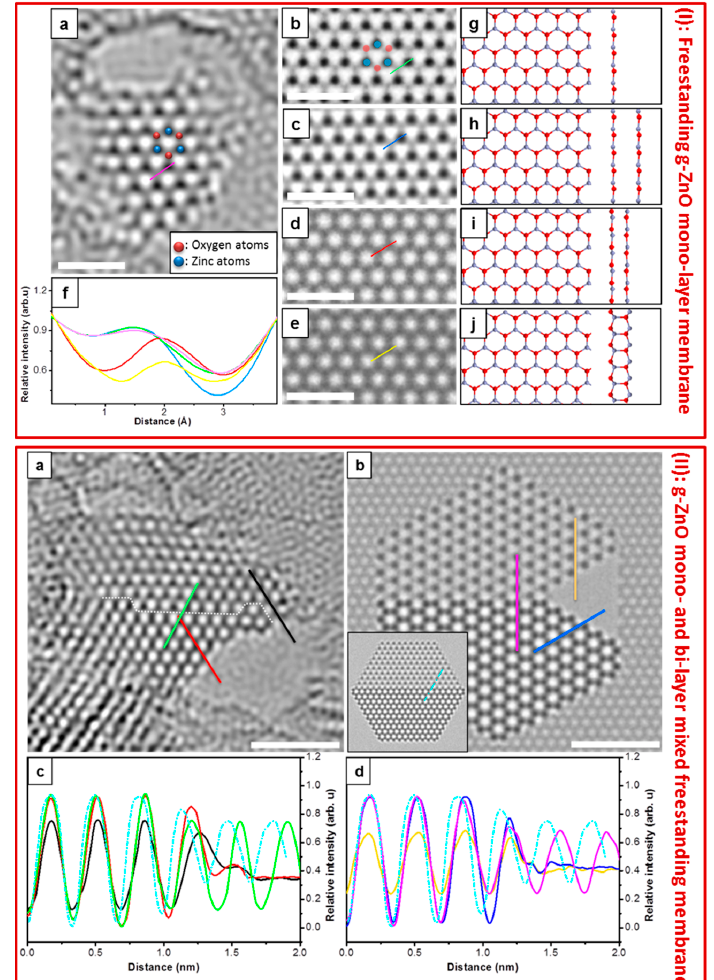
Figure 5. Frame ( I ): Mono-layer g-ZnO freestanding in a graphene pore. ( a ) TEM micrograph showing g-ZnO membrane within a graphene hole. ( b – e ) Simulated images of mono-layer and bi-layer T1, T2 configuration as well as wurtzite structure of ZnO, respectively. ( f ) Normalized intensity profiles from experimental image (pink line in panel a), simulated images of mono-layer (green line, panel b), bi-layer T1 (blue line, panel c), bi-layer T 2 (red line, panel d), bi-layer wurtzite (yellow line, panel e). ( g – j ) Atomic structure of ZnO corresponding to (b–e) images, respectively. All scale bars = 1 nm. Frame ( II ): Examination of mono- and bi-layer mixed g-ZnO freestanding membrane. ( a,b ) TEM and simulated images showing g-ZnO membrane with mono- and bi-layer mixed in a graphene hole. Inset: figure b shows mono- and bi-layer with a wurtzite structure. ( c ) Normalized intensity profiles from the TEM image corresponding to marked profiles in green line (bi-mono-layer), red line (bi-layer vacuum), black line (mono-layer vacuum) in panel a and light blue dashed line (wurtzite) in the inset of panel b. ( d ) Normalized intensity profiles from simulated image, corresponding to marked profiles in pink line (bi-mono-layer), dark blue line (bi-layer vacuum), yellow line (mono-layer vacuum) in panel b and light blue dashed line (wurtzite). All scale bars = 2 nm. Reprinted with permission from Reference [25]. Copyright © (2015) American Chemical Society.